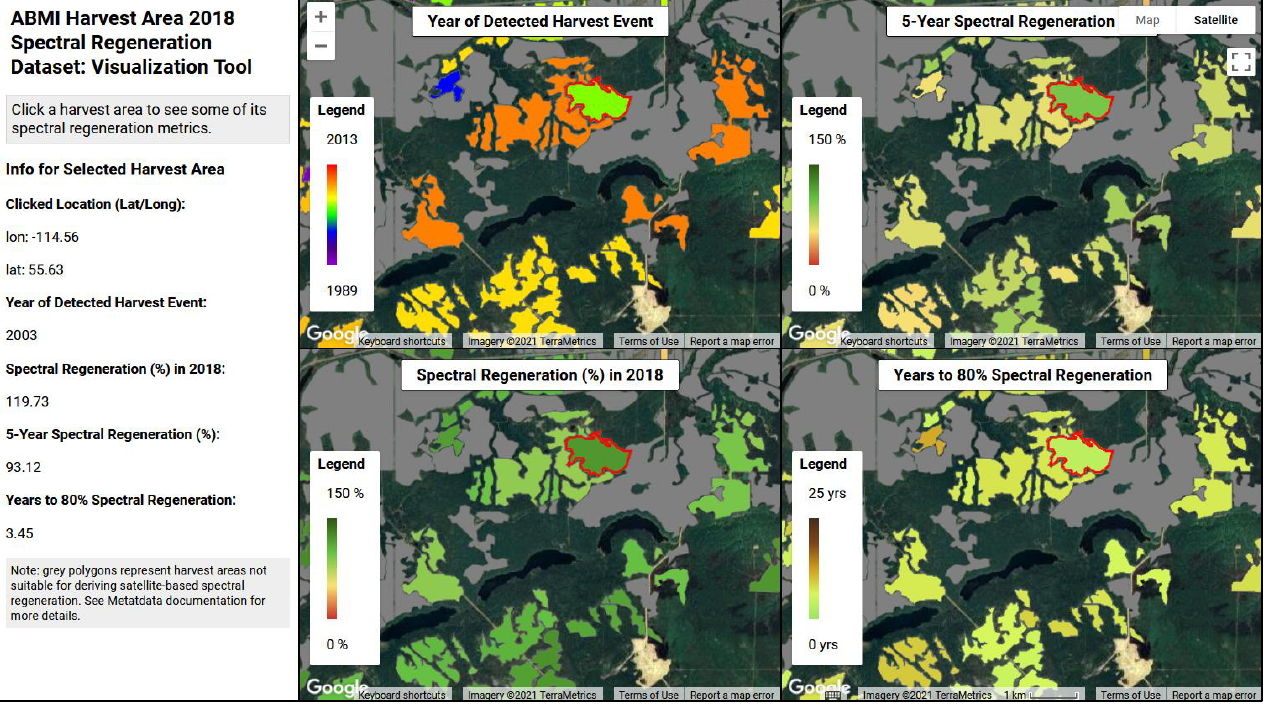
Figure 5. Screen shot showing the online visualization tool built for exploring the public 2018 harvest area spectral regeneration dataset.